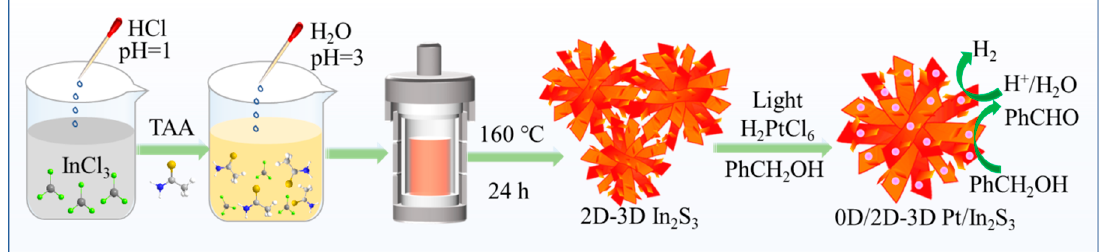
Figure 9. The preparation procedure of the 0D/2D-3D Pt/In 2 S 3